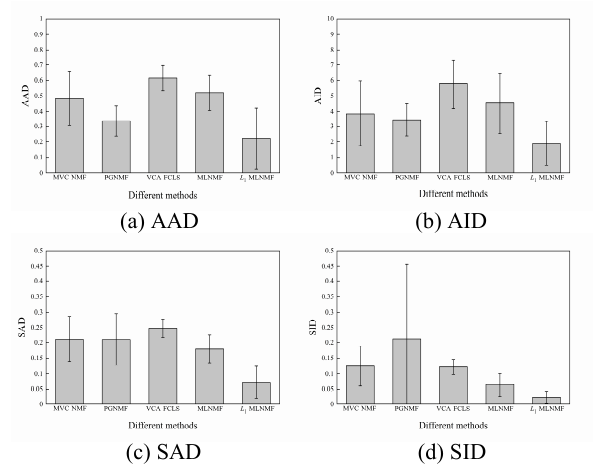
Figure 1. Performance comparison of different algorithms